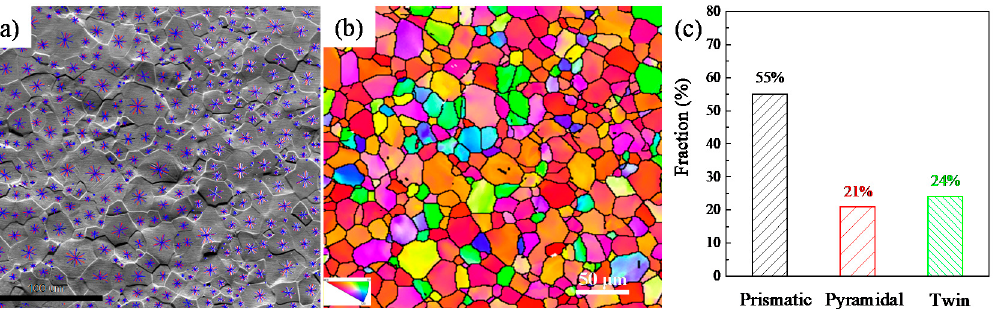
Figure 4. The analysis of deformation mechanisms of TA2 after a strain of ~2.9%: ( a ) SEM with the traces of different deformation modes; the traces of prismatic, basal, and pyramidal planes are indicated by the black, red, and blue lines, respectively; ( b ) IPF, ( c ) the fraction of different deformation modes.